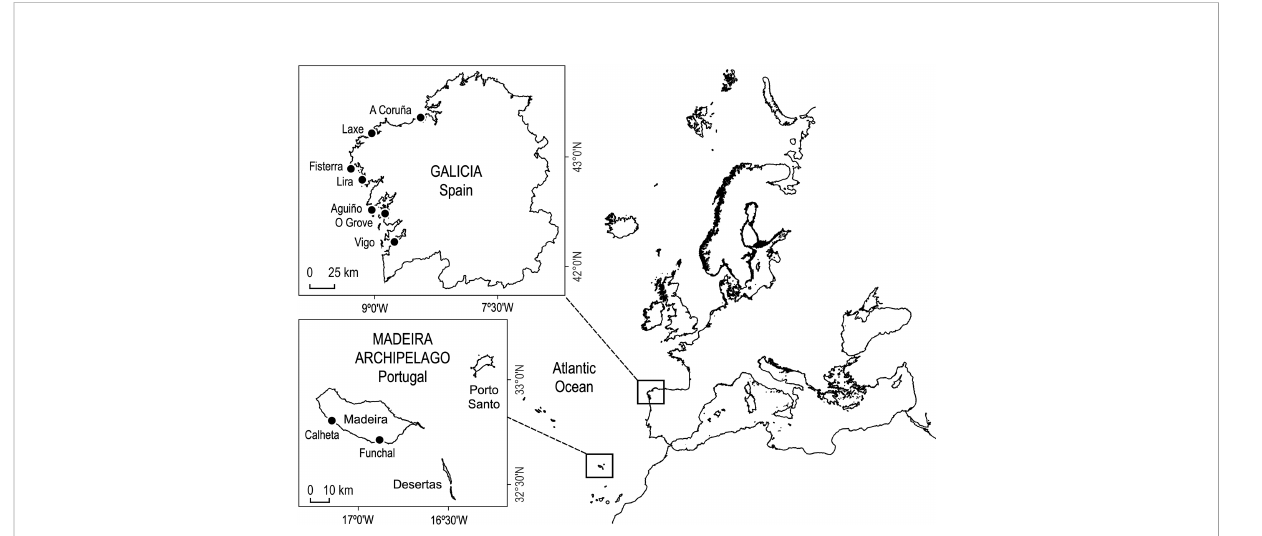
FIGURE 1 Map showing the location of Galicia (NW Spain) and Madeira archipelago (Portugal). We also show the marinas harboring recreational fi shing charter